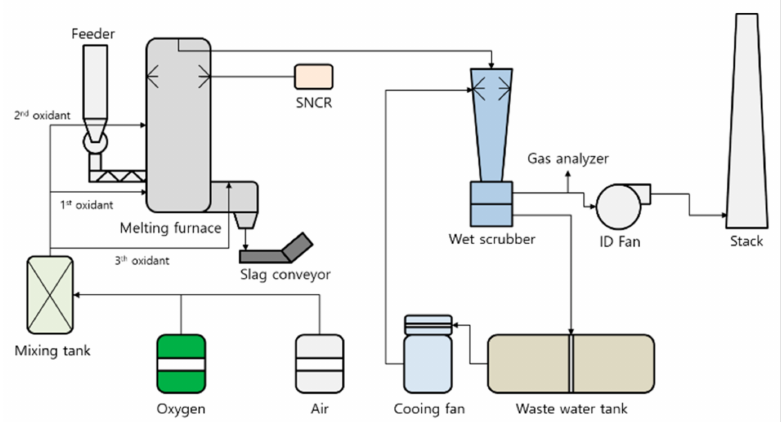
Figure 5. Schematic representation of the pilot-scale combustion melting plant components and processes. SNCR: selective non-catalytic reduction, ID fan: induced draft fan.